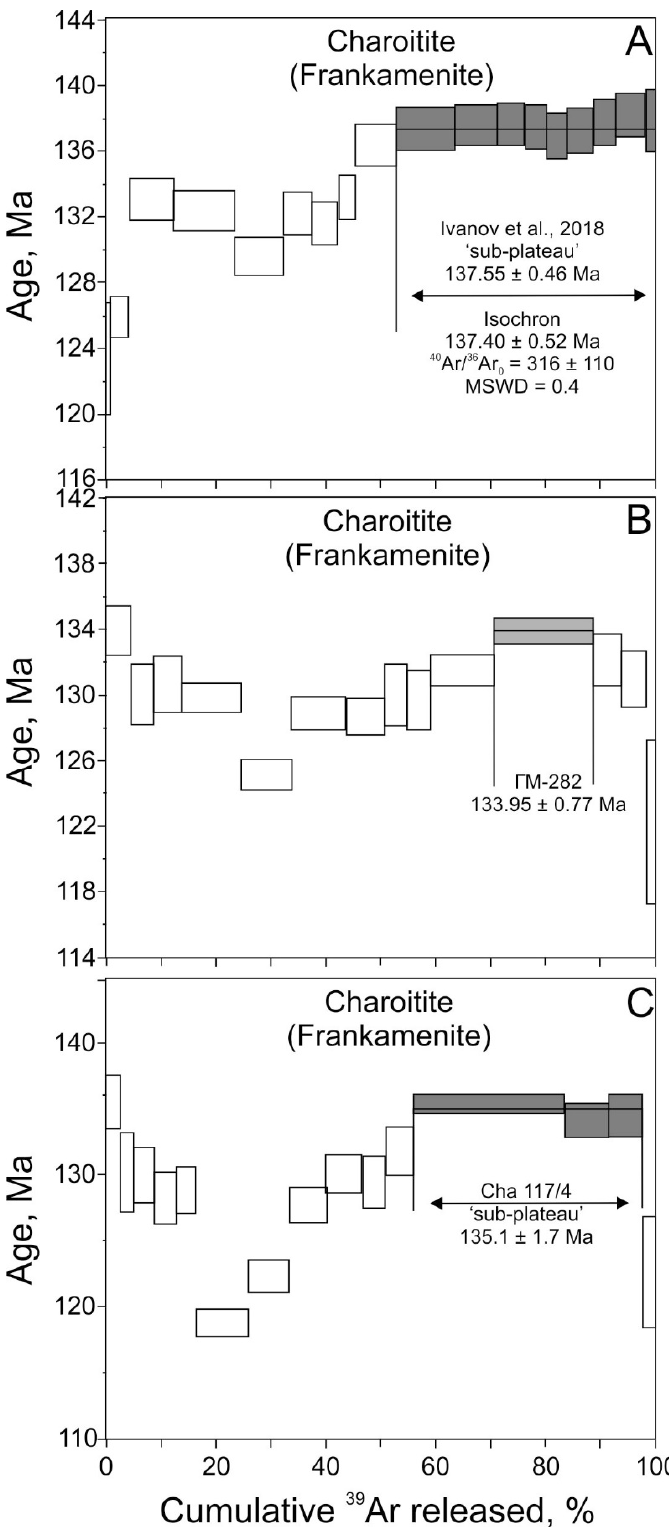
Figure 12. Argon release spectra for frankamenite (Ca 5 Na 3 K 3 (Si 12 O 30 )F 3 OH·nH 2 O) crystals of two different charoitite samples: ( A ) Obtained in [40], ( B ) frankamenite from the same museum sample reanalyzed in this study; and ( C ) frankamenite from another sample Cha 117/4. Steps used for calculation of sub-plateau and single step age values are shadowed.